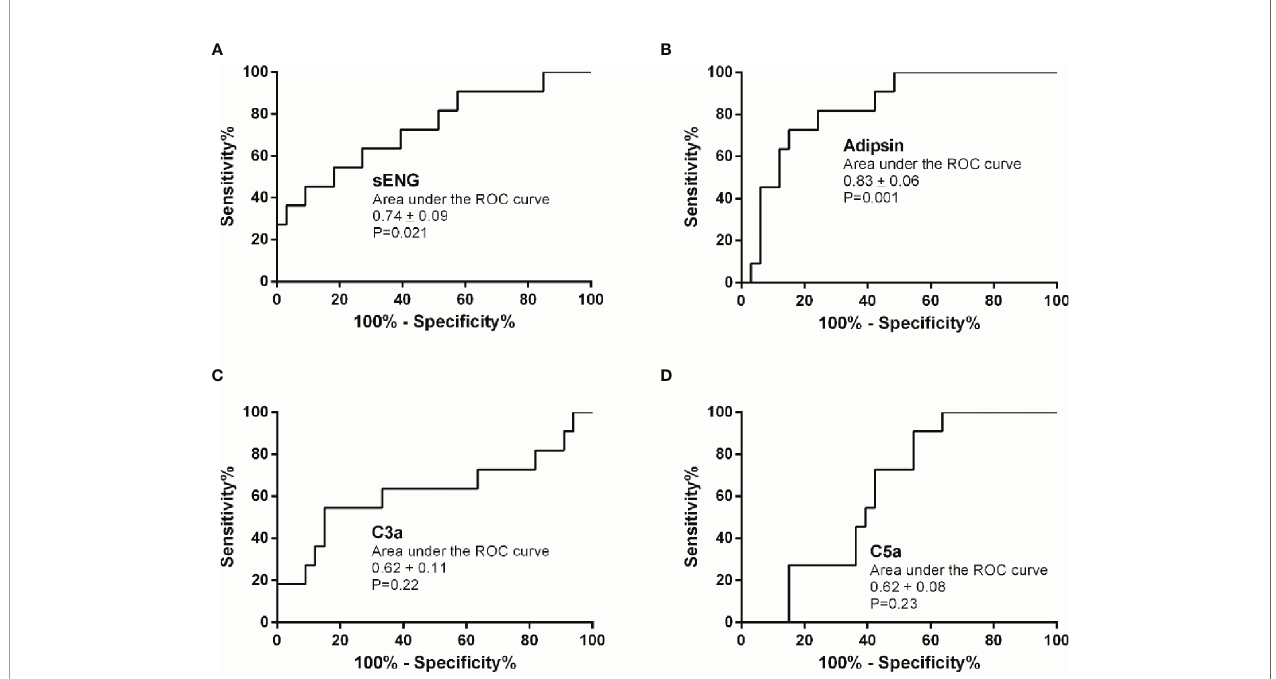
FIGURE 3 | Predictive value of sENG, adipsin, C3a, and C5a for preeclampsia. Receiver-operating characteristics (ROC) curves were plotted for sENG (A) , adipsin (B) , C3a (C) , and C5a (D) .